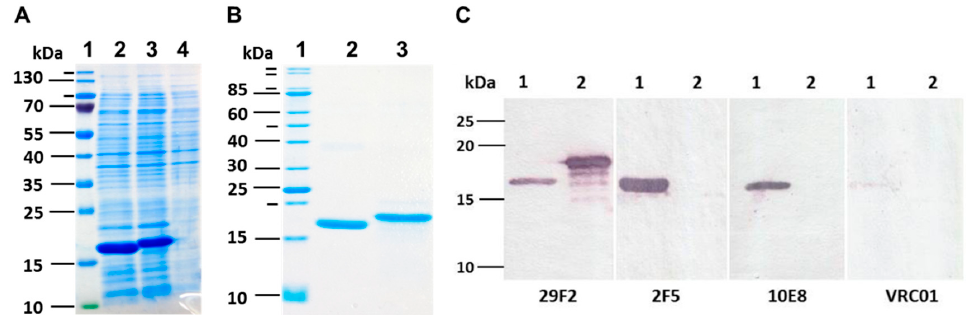
Figure 3. ( A ) SDS PAGE analysis of E. coli BL21 (DE3) pLysS cell lysate after IPTG induction.